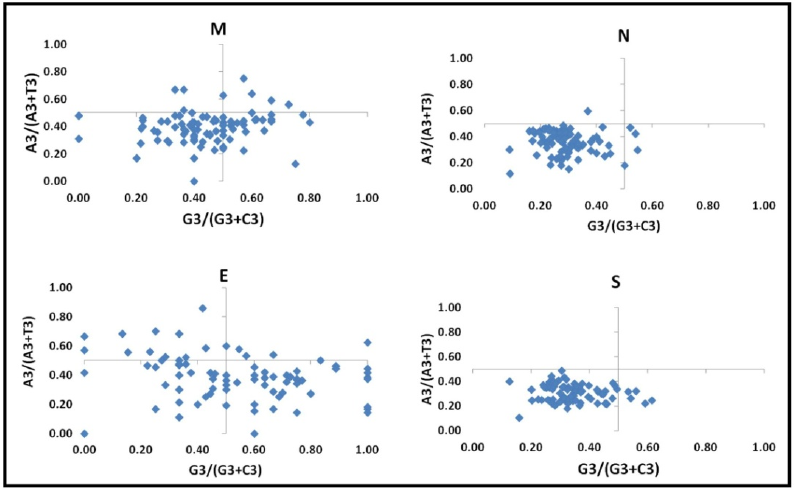
Figure 3. Parity rule-2 bias plot for the different structural genes of the Coronaviridae family: The nucleotide frequency at the third position of the four-fold degenerate amino acid was obtained using the MEGA software v. 7.0. A3/(A3 + T3) vs. G3/(G3 + C3) obtained for the different viruses are plotted as a blue point. The center of the ordinate and the abscissa is 0.5, which depicts unbiased usage of the codon.